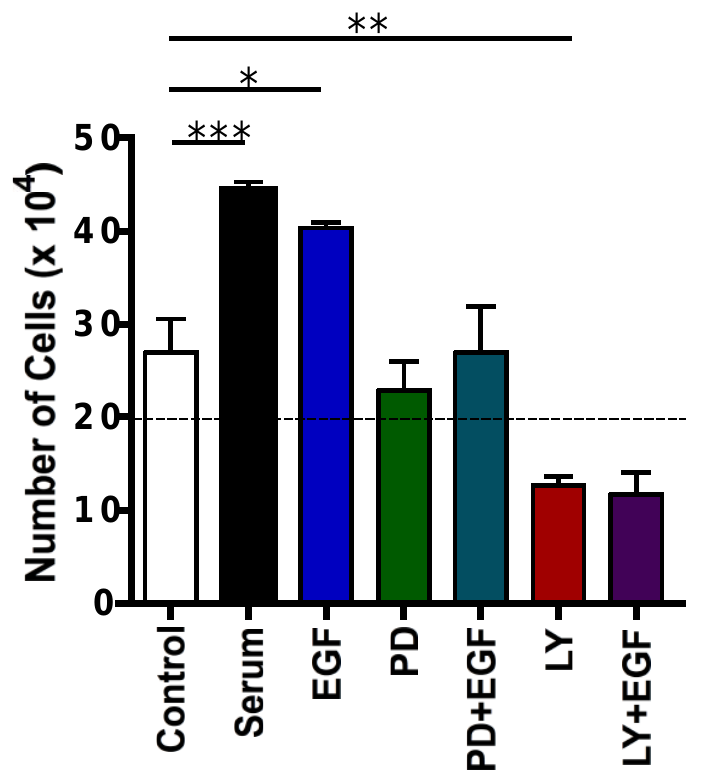
Figure 3. Effects of inhibitors on EGF-induced proliferation in C5 cells. Equal numbers of C5 cells (2 × 10 5 ) were plated and grown overnight. Cells were serum starved for 24 hours, then incubated for 24 hours in triplicate with and/or without 10% FBS (positive control), 10 nM EGF, 2 pM PD15878 (“PD”: EGFR inhibitor), or 25 µ M LY290042 (“LY”; PI3K inhibitor). Following treatment, viable cells were counted. The dashed horizontal line indicates the number of cells originally plated. Each data point represents mean ± SD for three wells of cells. Statistical significance was determined using t-test: * p < 0.05; ** p < 0.02; *** p <